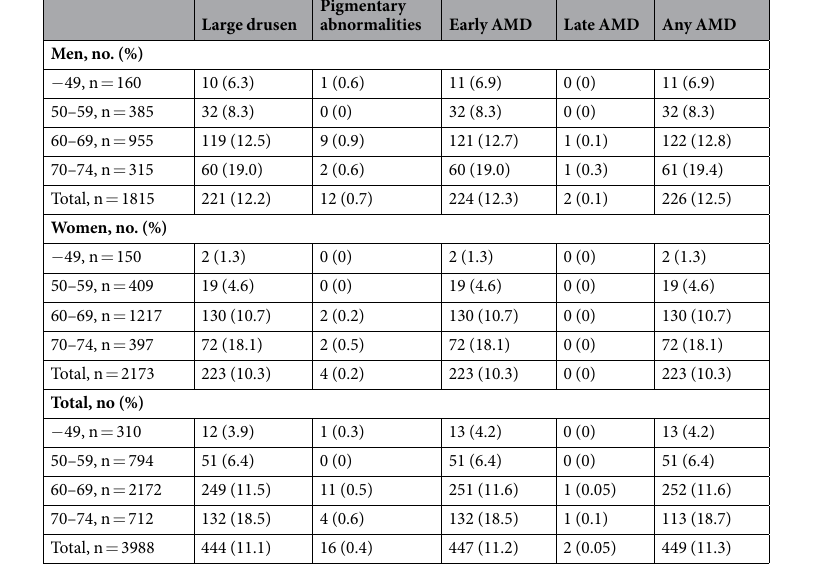
Table 1. Age-specific prevalence of early and late AMD according to sex.